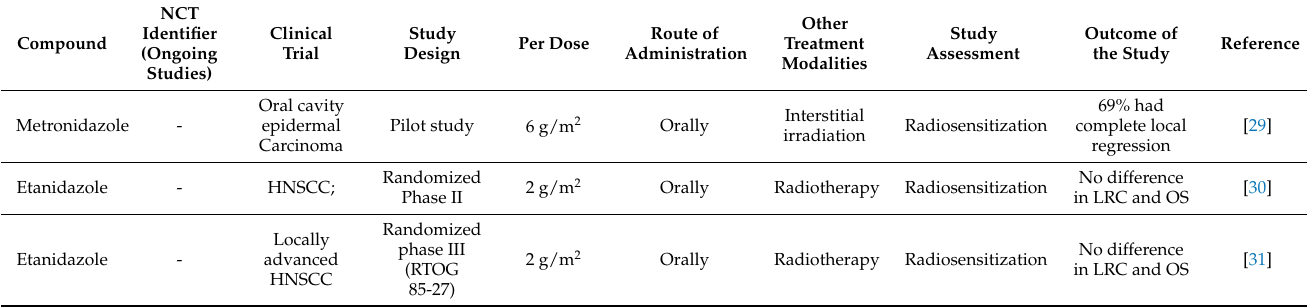
Table 1. Comparison of different imidazole-based compound in clinical trials done in patients with